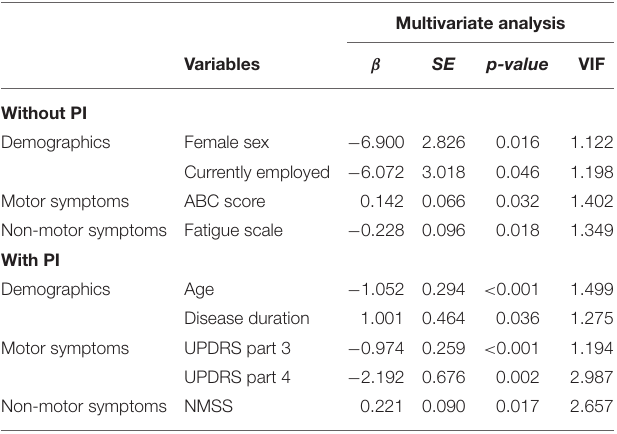
TABLE 2 | Multivariate linear regression analyses of the associations of PASE score and clinical factors.